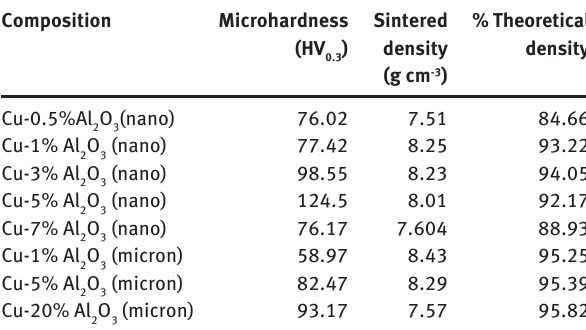
O microcomposite sintered by SPS. 2 3